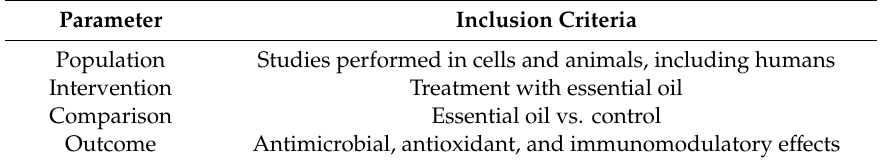
Table 1. PICO (Population, Intervention, Comparison, Outcome) criteria for inclusion of